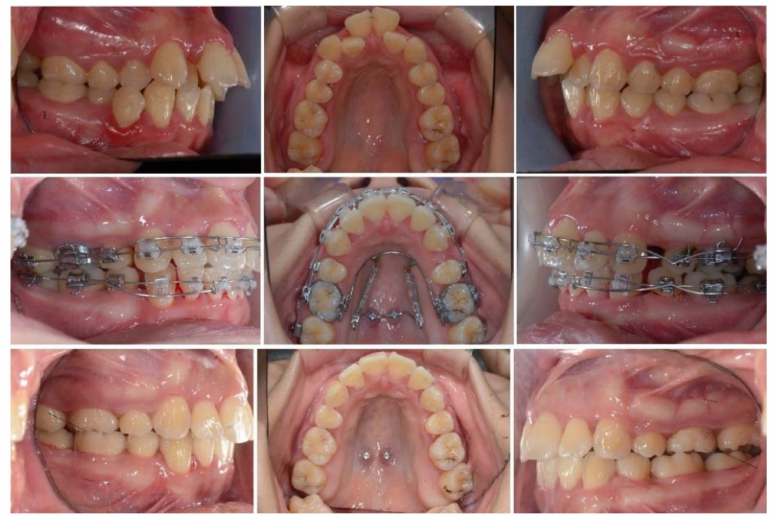
Figure 3. The TADs were inserted on the palatal side and lingual arch appliance was placed on the palate and connected to the palatal bar installed on the maxillary first molars for maxillary molar distalization (group 2) From the upper: pretreatment, during treatment, and